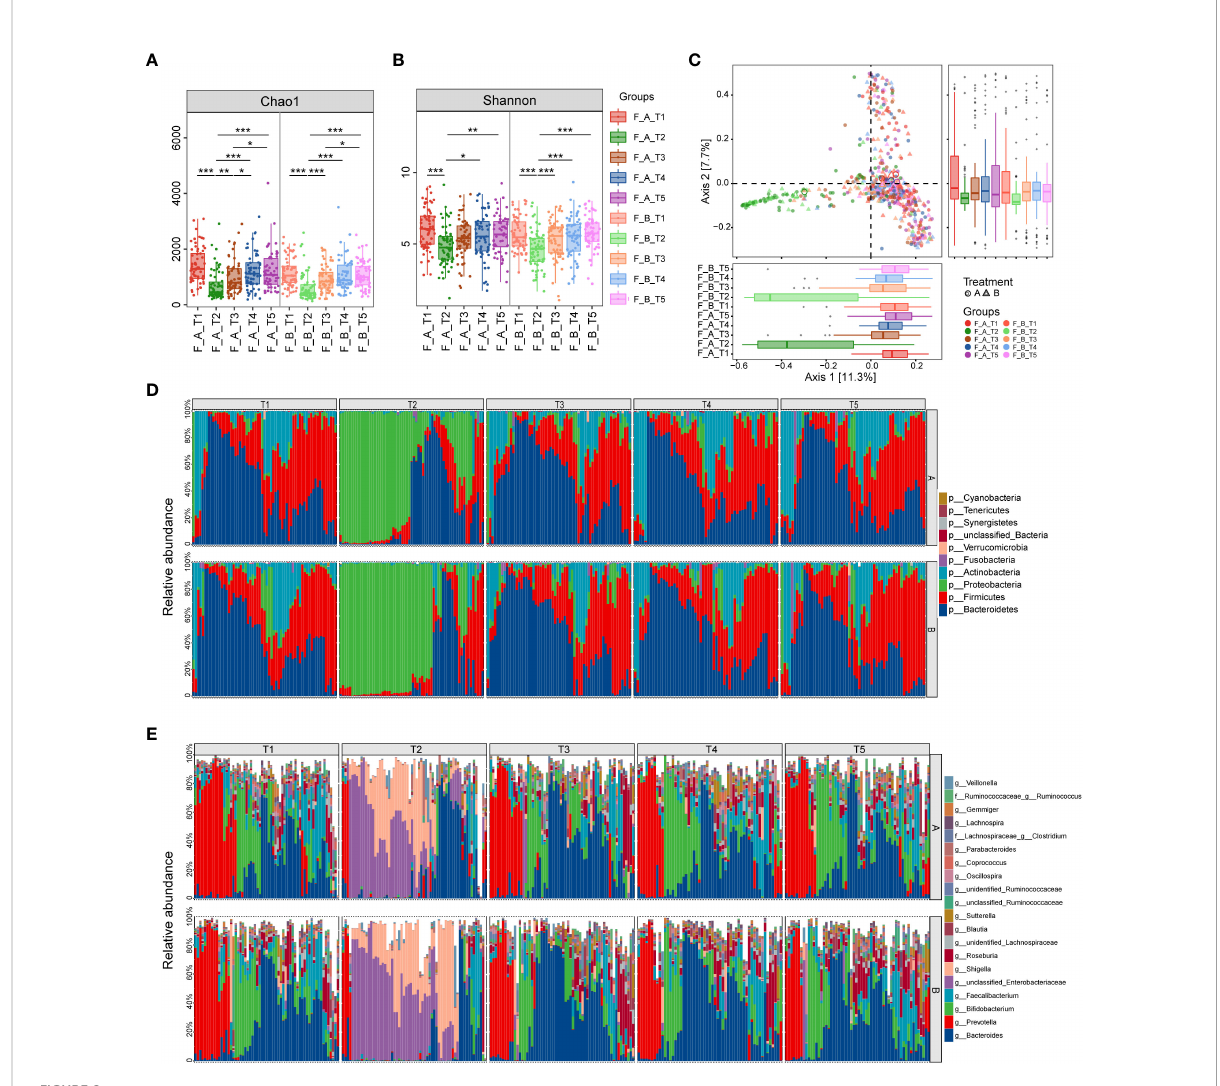
FIGURE 2 Comparison of diversity and composition of gut microbiota after eradication therapy. (A, B) Alpha diversity, representing the richness of microbiota, was signi fi cantly reduced immediately following eradication treatment (T2) and then gradually returned to baseline from T3 to T5. (C) Principal coordinate analysis (PCoA) based on Bray-Curtis distances revealed the overall microbiota composition differed between T2 and other time points. (D) Relative proportions of the top 10 bacterial phyla. (E) Relative proportions of the top 20 bacterial genera. A, probiotics group; B, placebo group; T1, pretreatment; T2, cessation of quadruple therapy; T3, 2 weeks after quadruple therapy; T4, 8 weeks after quadruple therapy; T5, 24 weeks after quadruple therapy; *, p<0.05; **, p<0.01, ***,